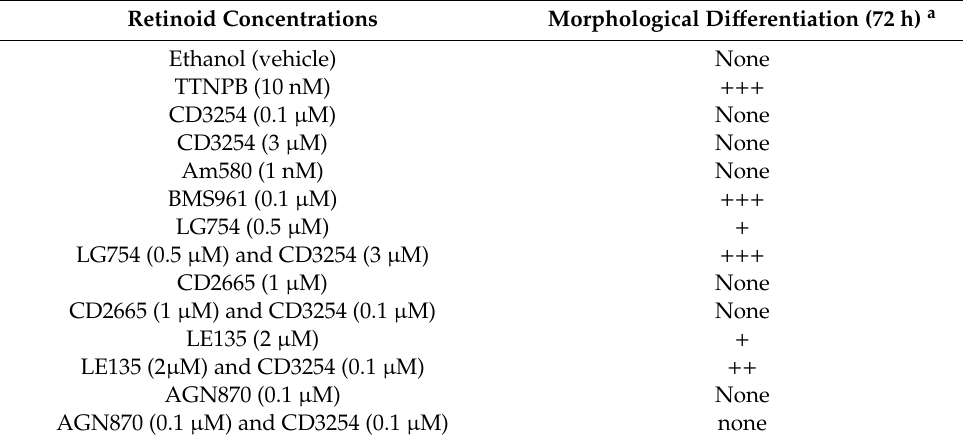
Table 1. Synergistic e ff ect of synthetic retinoids on F9 cell di ff